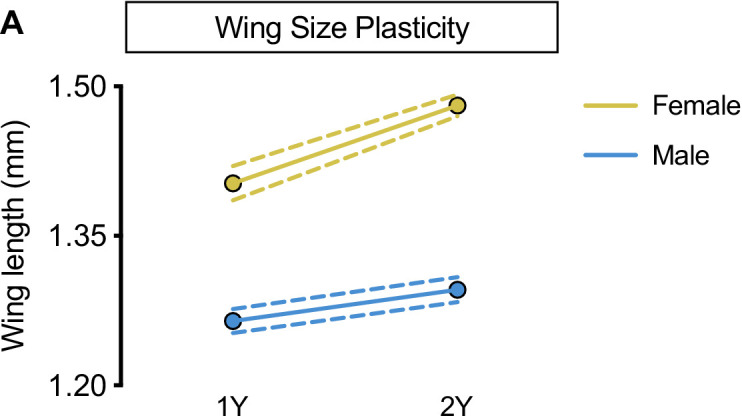
Increased nutrient-dependent plasticity in female wing size.(A) Wing length was significantly higher in both w1118 females and males reared on a protein-rich diet (2Y) compared with genotype-matched females and males cultured on a diet containing half the protein (1Y) (p<0.0001 and p=0.0018, respectively; two-way ANOVA followed by Tukey HSD test). The magnitude of the nutrient-dependent increase in wing length was higher in females (sex:diet interaction p=0.0004; two-way ANOVA followed by Tukey HSD test). n = 16–28 wings. For wing size plasticity graphs, filled circles indicate mean wing length, and dashed lines indicate 95% confidence interval.